Question: Give a one-sentence summary of this figure.
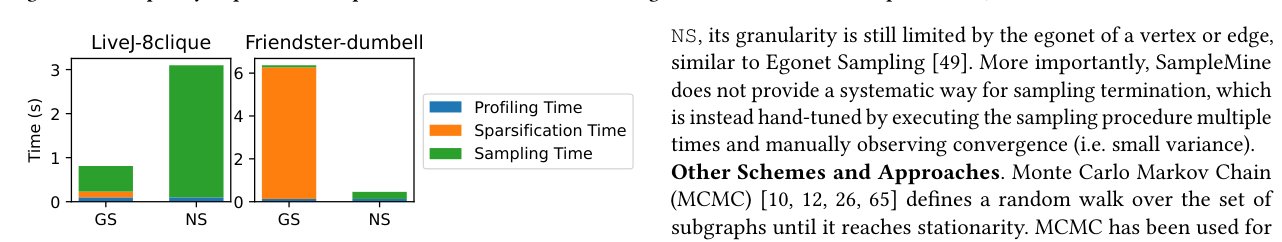
Answer: End-to-end time breakdown of ScaleGPM.